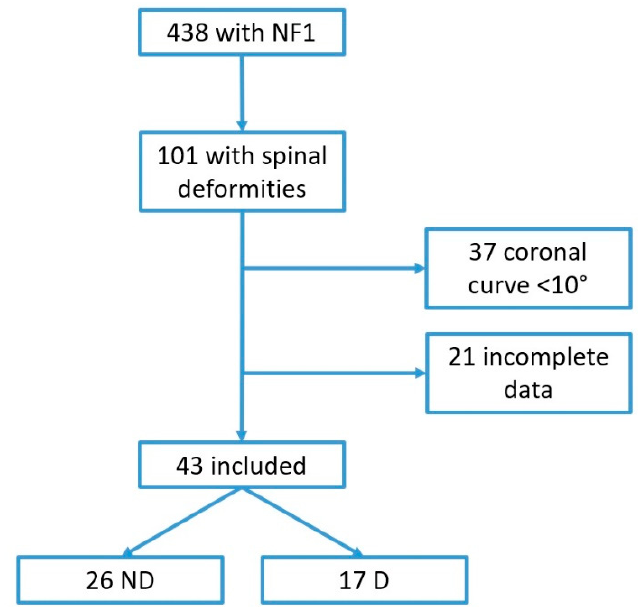
Figure 1. Flowchart of population selection.